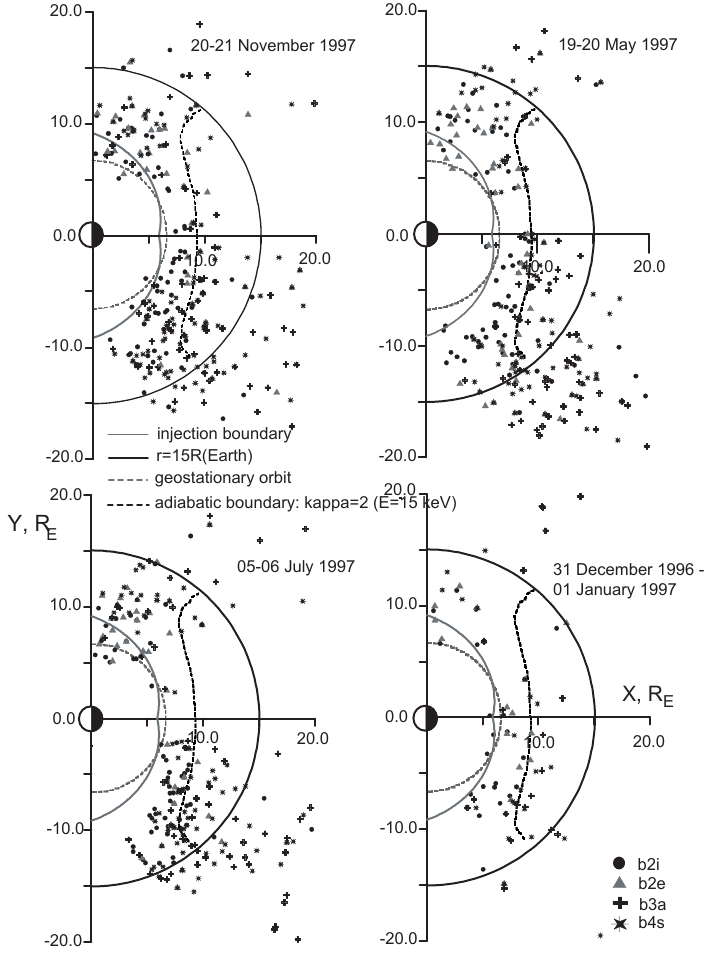
Fig. 4. Location of DMSP particle boundaries in the equatorial plane for the selected events. The “b2i”, “b2e”, “b3a”, “b4s” boundaries are shown (see text). For comparison, the locations of the geostationary orbit, “injection boundary”, boundary R B = 15 R E , and “adiabatic boundary” calculated for the parameter κ = 2, are